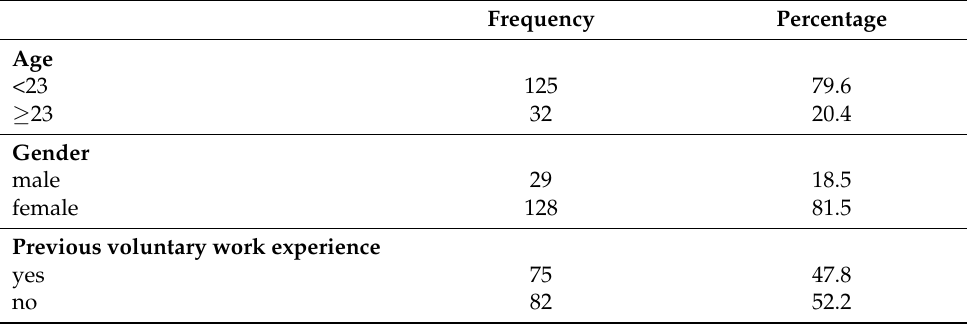
Table 1. Demographic information of participants (Total =